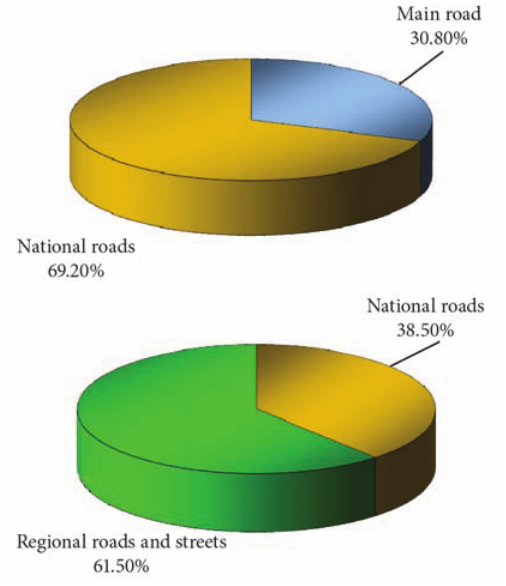
Fig. 8. The share of major and minor roads of roundabouts